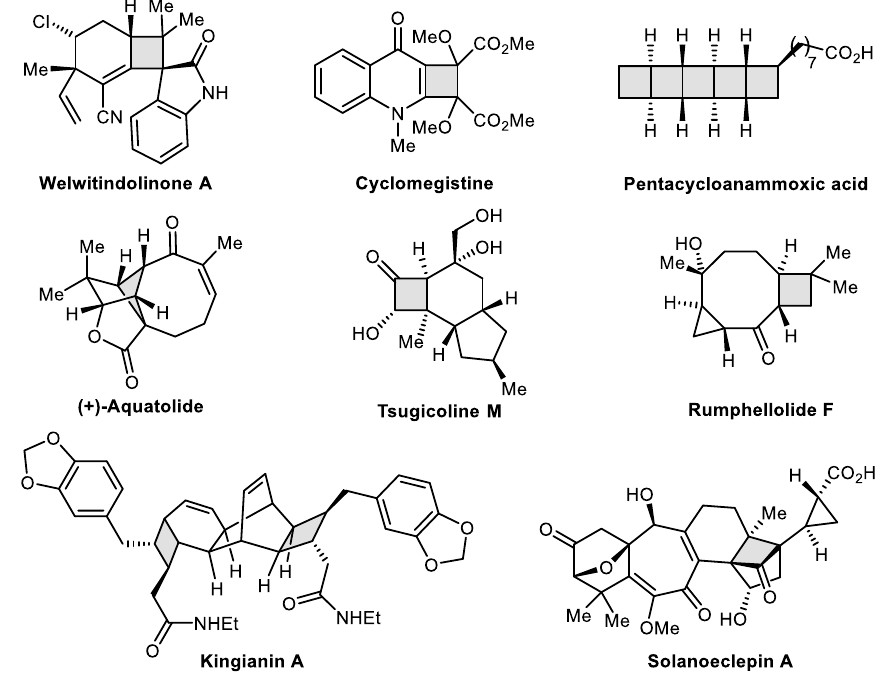
Figure 1. Natural products containing four-membered rings in their skeleton.